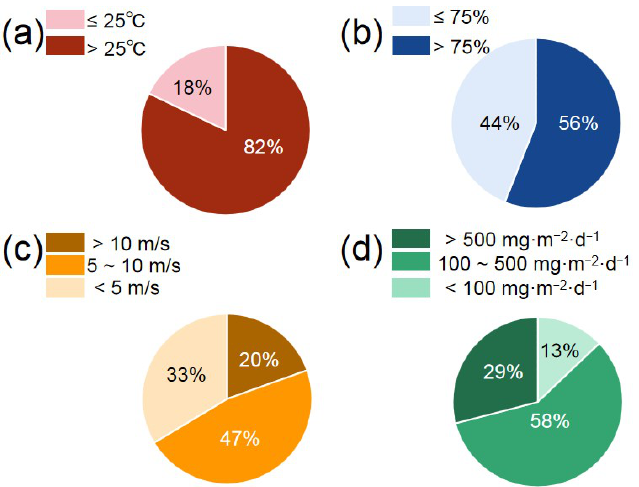
Table 2. The range and average value of environment factor during exposure period.